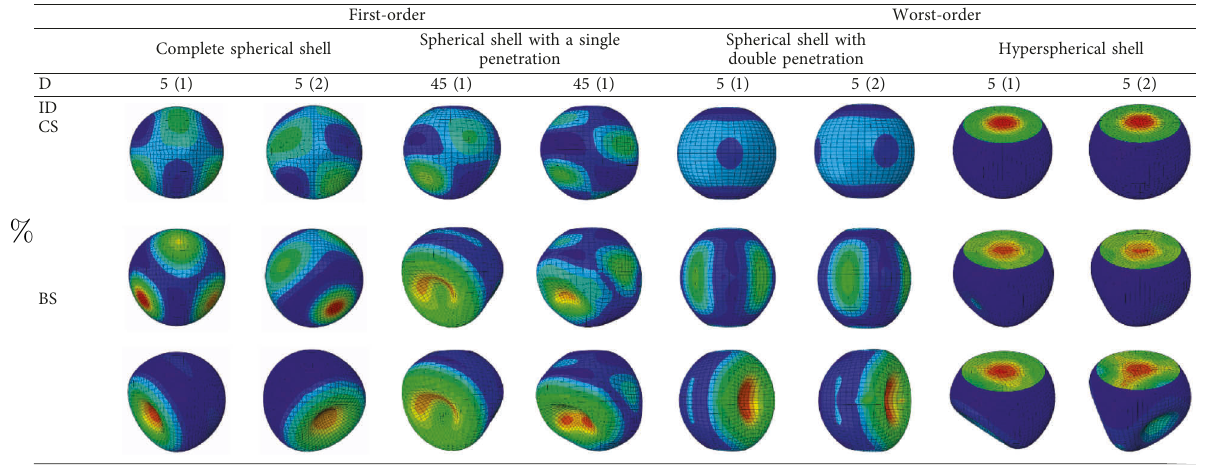
Table 3: Comparison between 1st-order and N -order modal methods in buckling